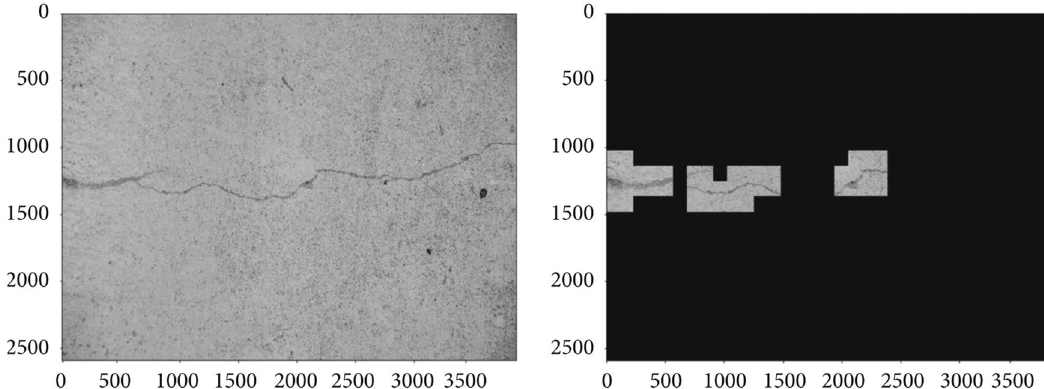
Figure 2. Failed automatic unsupervised crack detection (courtesy of 28